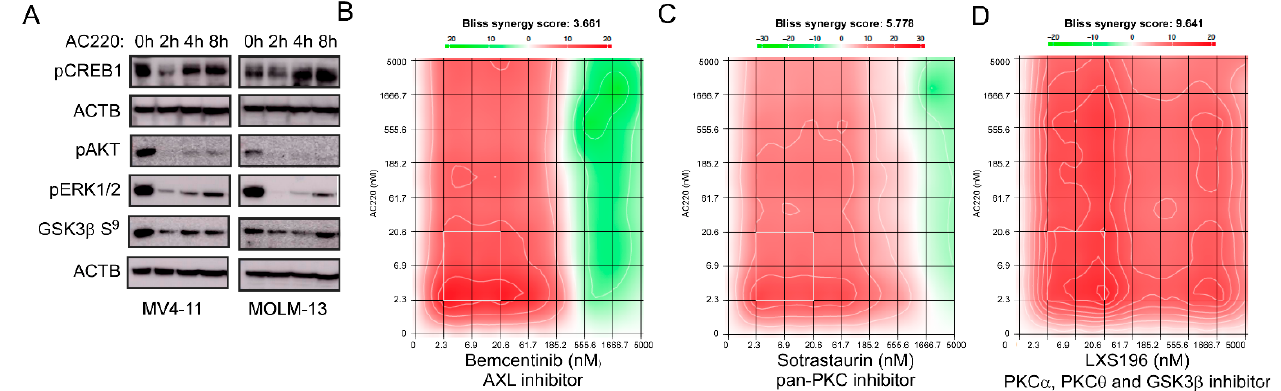
Figure 5. FLT3 inhibition enhances CREB phosphorylation and displays synergy with AXL and PKC inhibitors. ( A ) MV4 − 11 and MOLM − 13 cells were treated with AC220 for different time points before lysis. Lysates were used to separate by SDS − PAGE following western blotting using different antibodies. ( B – D ) MV4 − 11 cells were treated with a single drug or a 1:1 drug combination for 48 h. Relative inhibition was used to calculate the synergy as described in material methods. A positive BLISS score represents the synergy (single drug response curves are presented in the supplementary figure S5).